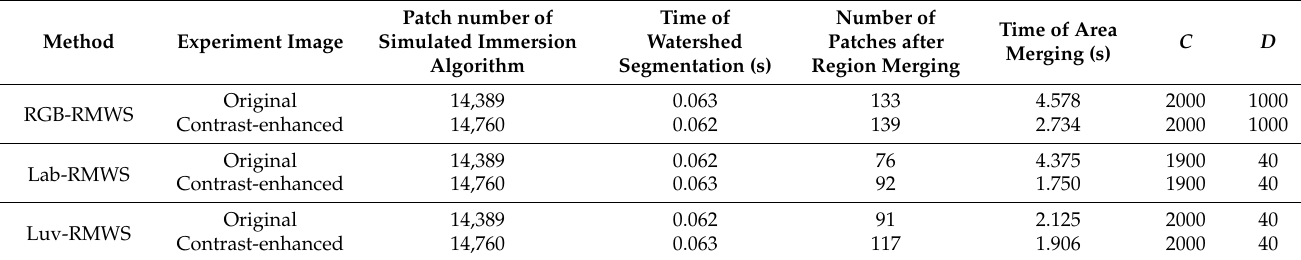
Table 2. Statistical features derived from the three methods. RGB: Red–Green–Blue; RMWS: Region merging watershed